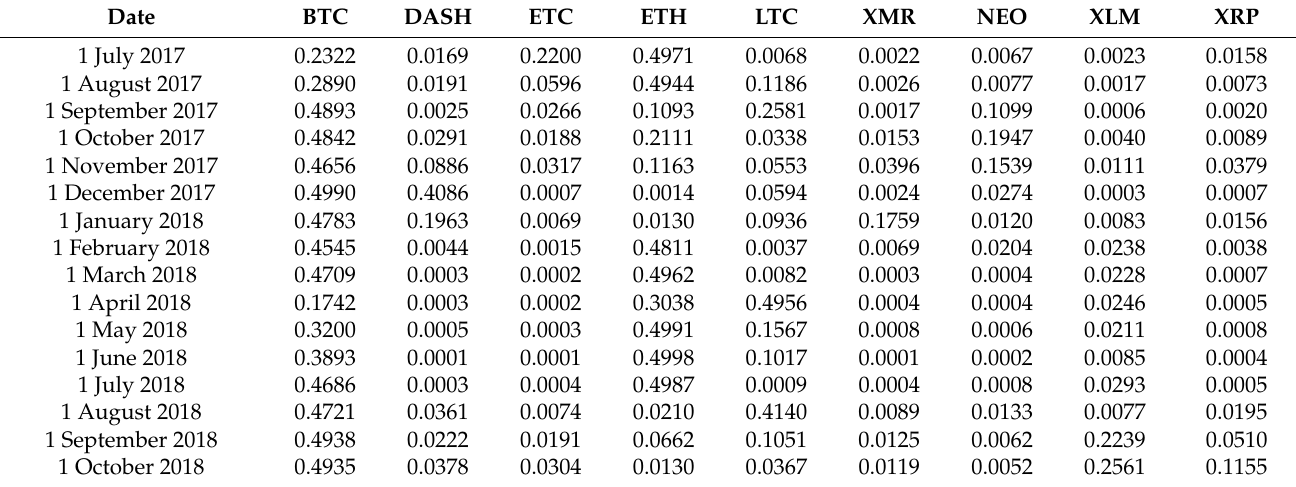
Table 4. Optimal portfolios with the weights of each